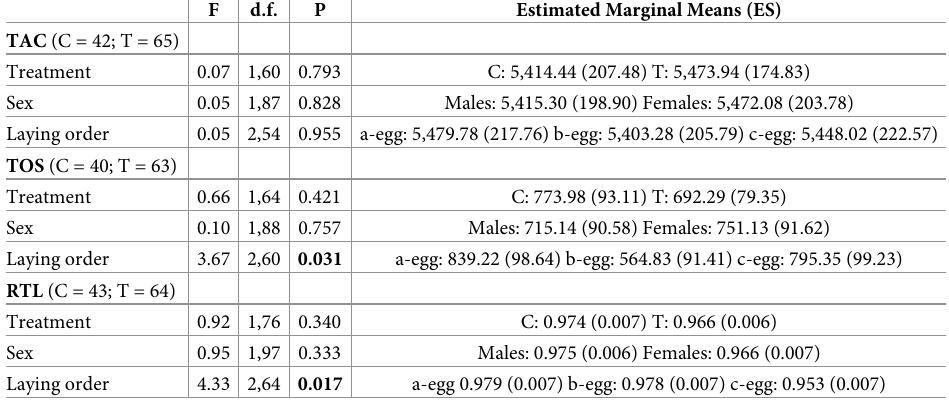
Table 1. Linear mixed models of total antioxidant capacity (TAC), amount of pro-oxidant molecules (TOS) and relative telomere length (RTL) in blood of yellow-legged gull hatchlings in relation to testosterone treatment, sex, and laying order. Clutch identity was included in the models as a random intercept effect. The non-significant effects of the two-way interactions between fixed factors were excluded from the final model. C = control; T = testosterone- injected (the amount of hatchling per each experimental group is reported in brackets). Significant effects are reported in bold. F